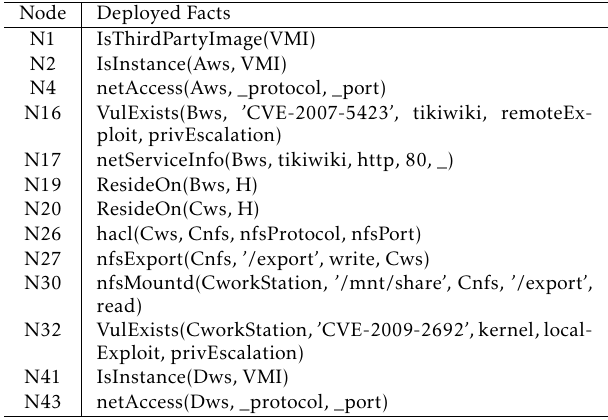
Table 2. Network Deployment